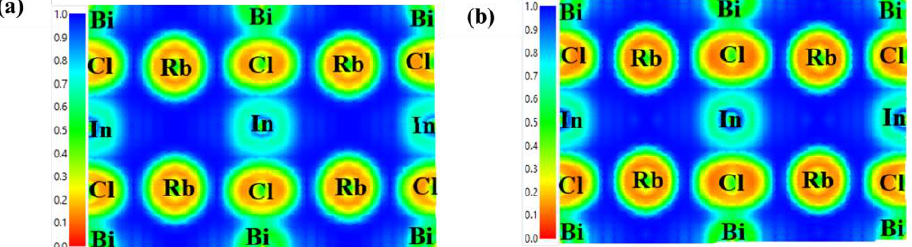
Figure 5. ( a , b ) Electron localization function (ELF) for Rb 2 InBiX 6 (X = Cl, Br) compounds along (100) plane .